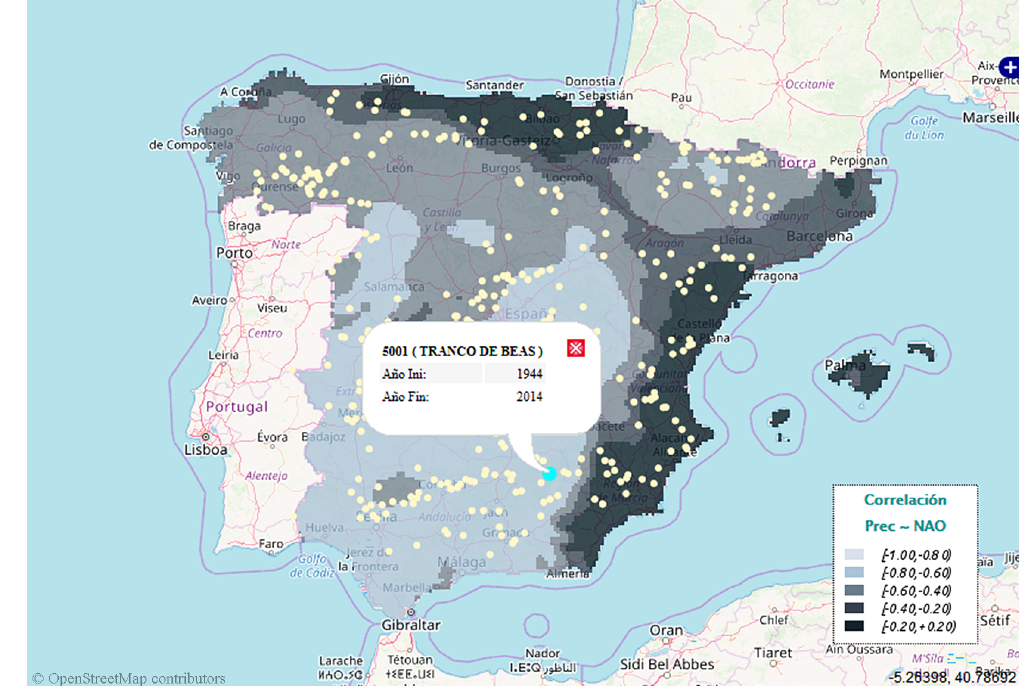
Figure 2. Main panel in diagnostic view showing the selected Tranco de Beas reservoir. © OpenStreetMap contributors 2019. Distributed under a Creative Commons BY-SA License.